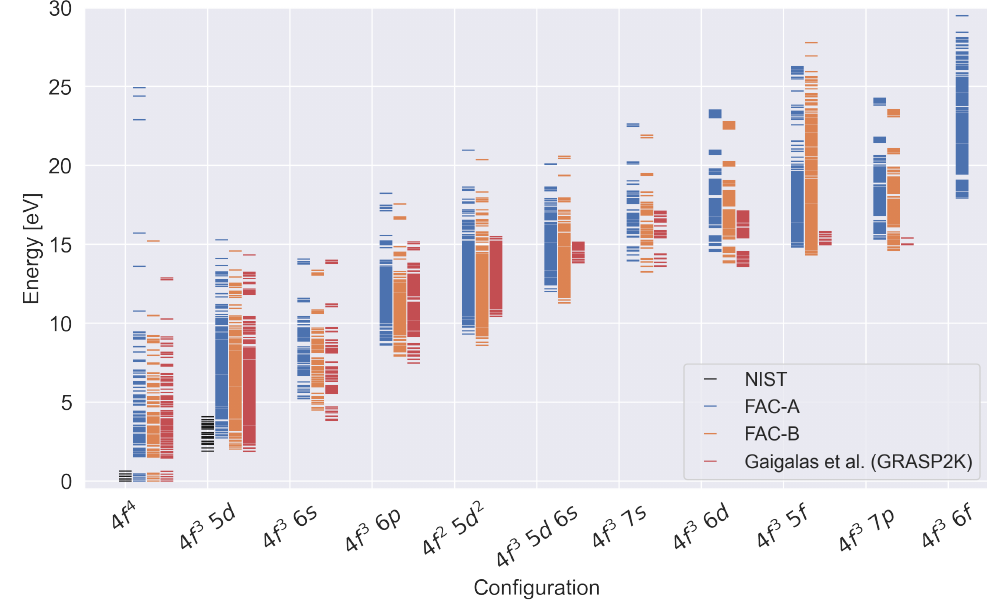
Figure 1. Energy levels for configurations of Nd III calculated with FAC and compared with the results from Gaigalas et al. [22] and with NIST data